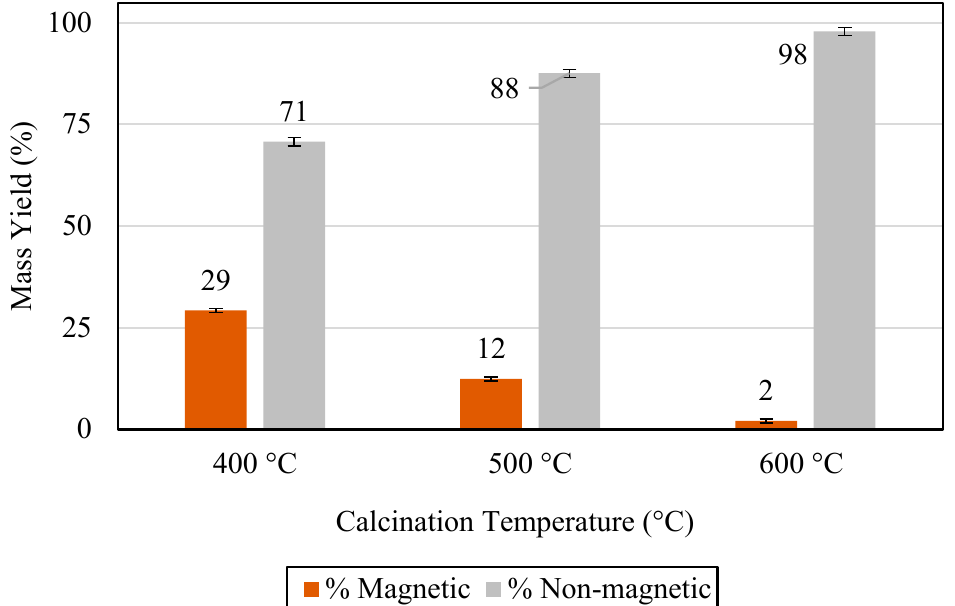
Figure 5. The mass yield obtained from magnetic separation tests on calcined products of the 2.20 SG sink fraction of Baker seam coal generated at three temperatures under a field strength of 11,500 Gauss.